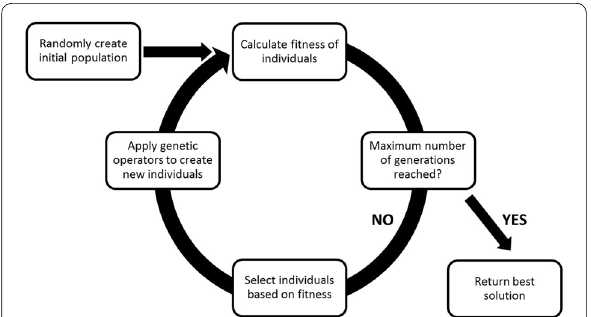
Fig. 1 A graphical high-level overview of the GP